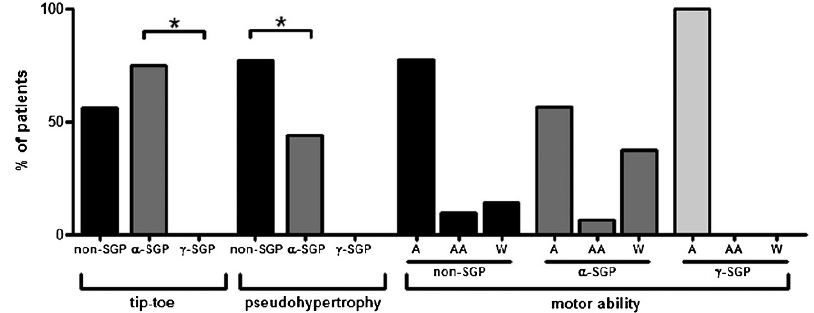
Figure 3 - Histograms illustrating the clinical findings. First, the percentage of patients in each group presenting with a tiptoe gait pattern are shown. The Kruskal-Wallis test showed a significant difference between the a -SGP and c -SGP groups ( p =0.03). Second, the percentage of patients in each group with calf pseudo-hypertrophy is shown. The Kruskal-Wallis test showed a significant difference between the a -SGP and c -SGP groups ( p =0.02). Third, the maximum motor ability of the groups is shown. 37.5% of the patients with an a -SG deficiency were confined to a wheelchair, while only 12% of the patients with a c -SG deficiency and none of the non-SGP patients were wheelchair bound. non-SGP: positive staining for all sarcoglycans; a -SGP: a -sarcoglycanopathy; c -SGP: c -sarcoglycano-